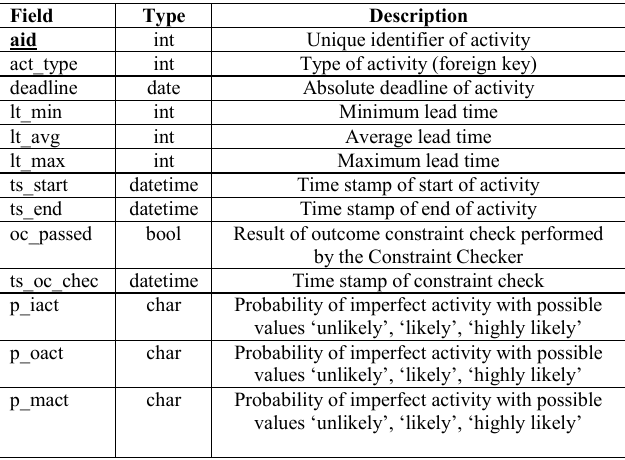
D ATABASE T ABLE ‘A CTIVITY